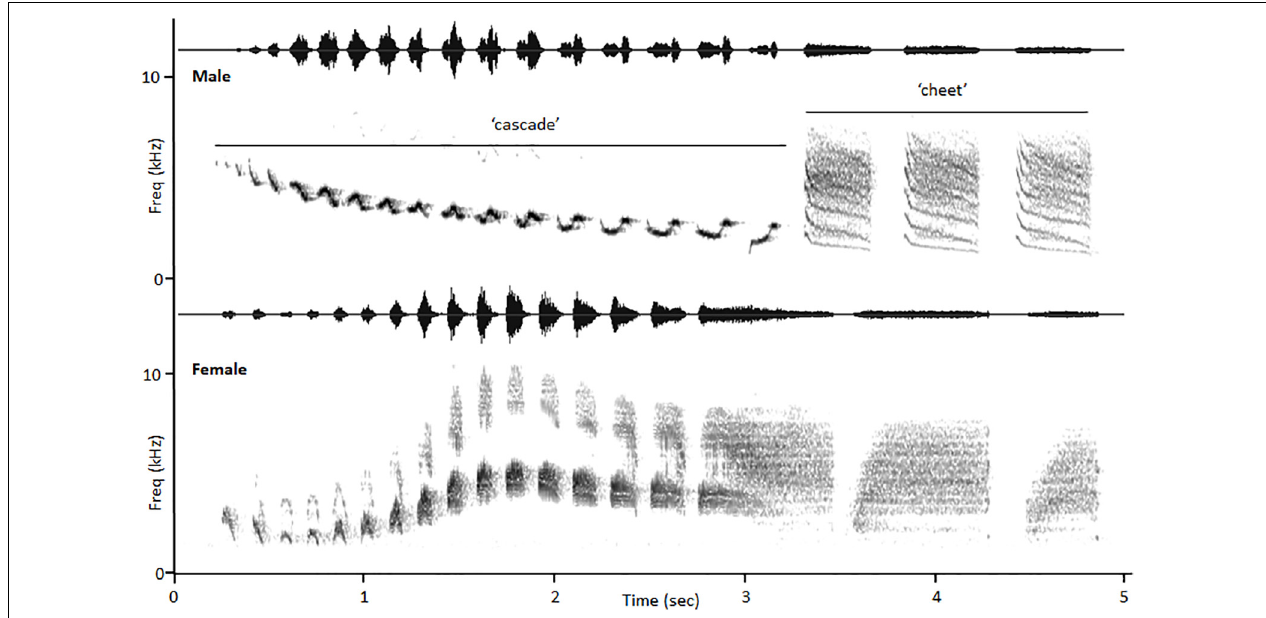
FIGURE 1 | Spectrograms of male and female canyon wren songs, with the “cascade” and “cheet” portions of the male song indicated. Songs were recorded from a mated pair in Arizona (GIS: 31.908498, − 109.188094) on June 7,